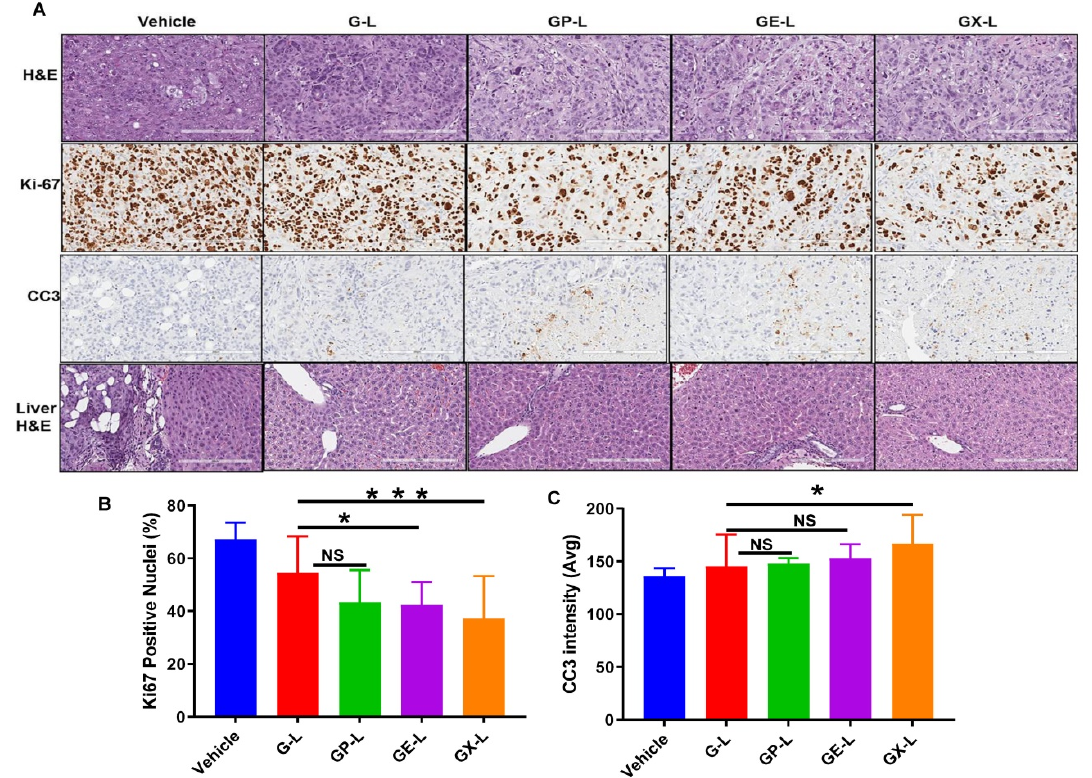
Figure 7. H&E, Ki67, and CC3 staining of tumor sections and liver H&E obtained from respective treatment groups. ( A ) Representative images of the H&E- and Ki67-stained tumor sections from different treatment groups displayed the comparatively higher antiproliferative activity of dual drug-loaded liposomes than gemcitabine-loaded liposomes and untreated. Quantification of Ki67-positive nuclei ( B ) and average CC3 positive intensity (avg) ( C ) of tumor sections. * and *** denotes p < 0.05 and p < 0.001 compared to G-L, respectively.